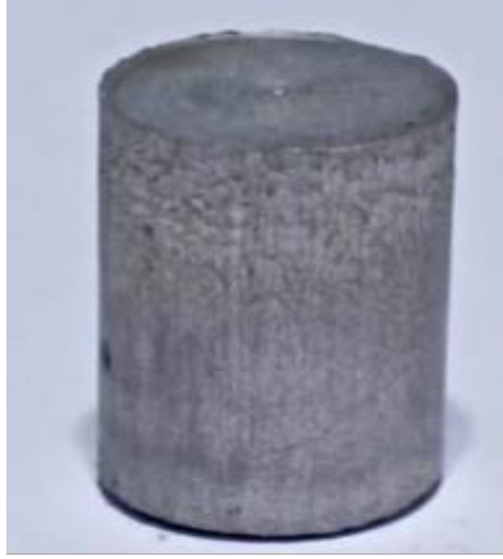
Figure 1. The schematic diagram represents the steps used for the preparation of FGCs.